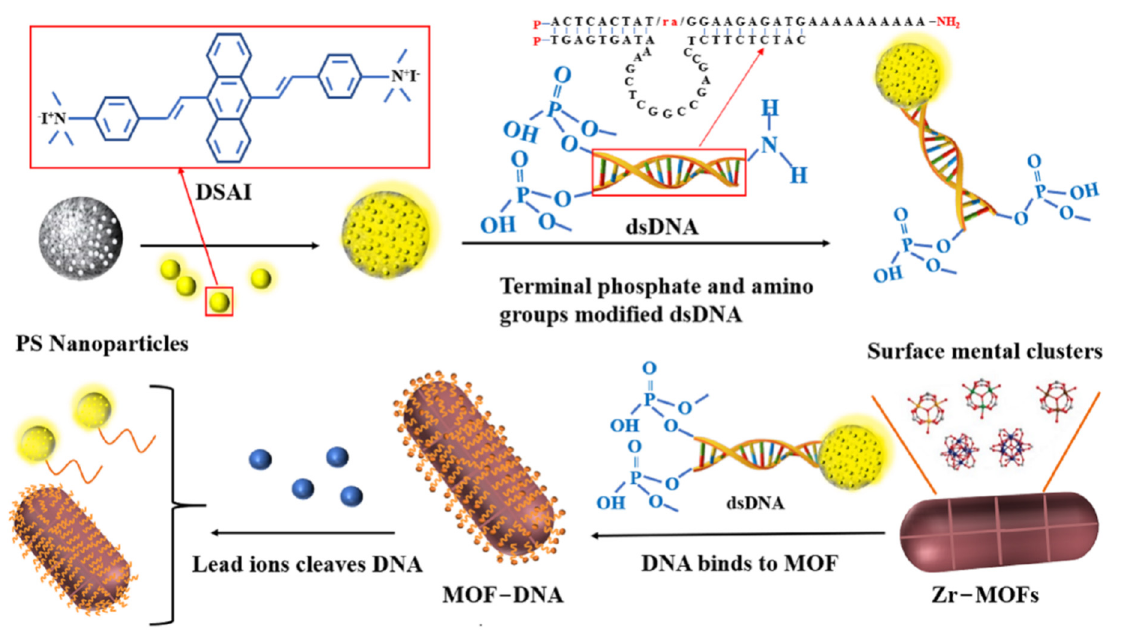
Figure 1. Schematic diagram of AIEgen nanosphere-labelled aptamer combined with Zr-MOFs for detection of Pb 2+.